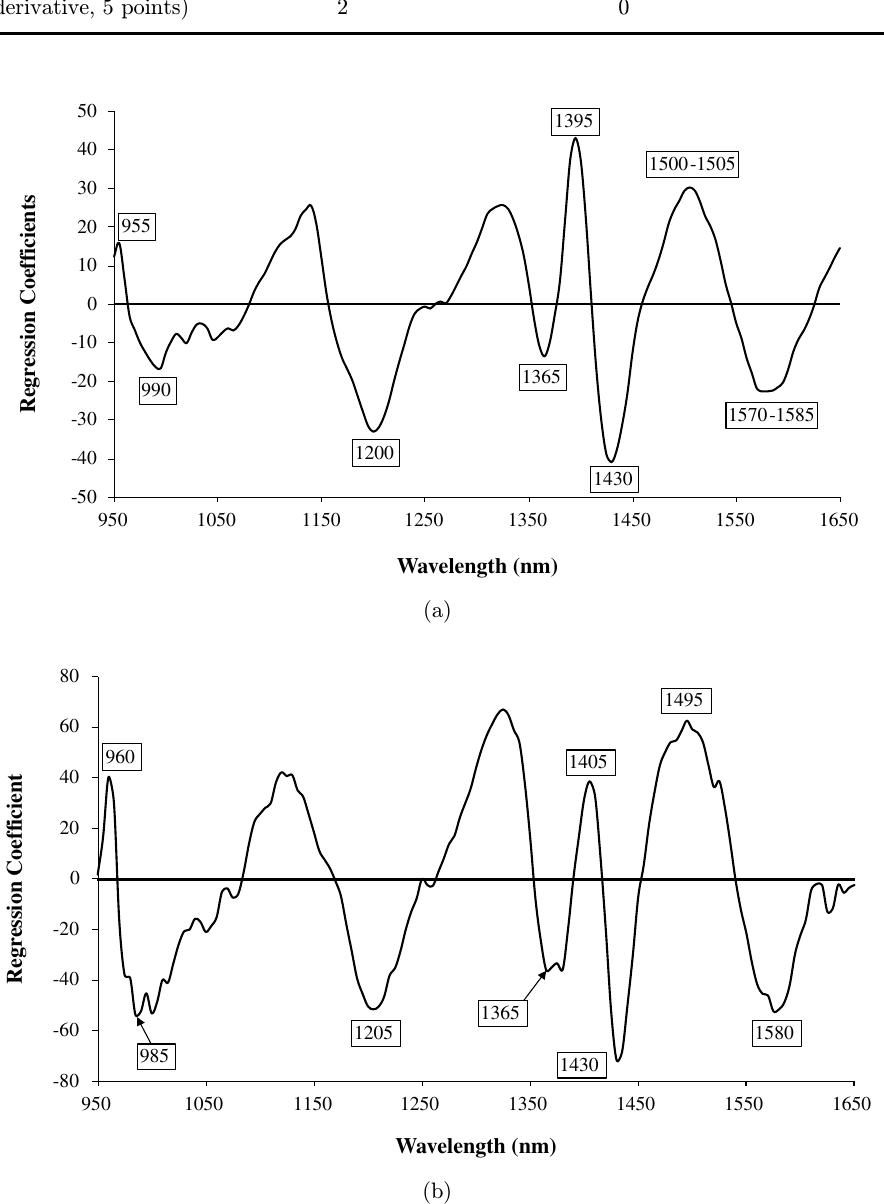
Fig. 2. Regression coe±cient plots of optimum models for moisture content in tapioca starch. (a) Tapioca starch cake samples. (b) Dried tapioca starch samples. (c) Combined tapioca starch